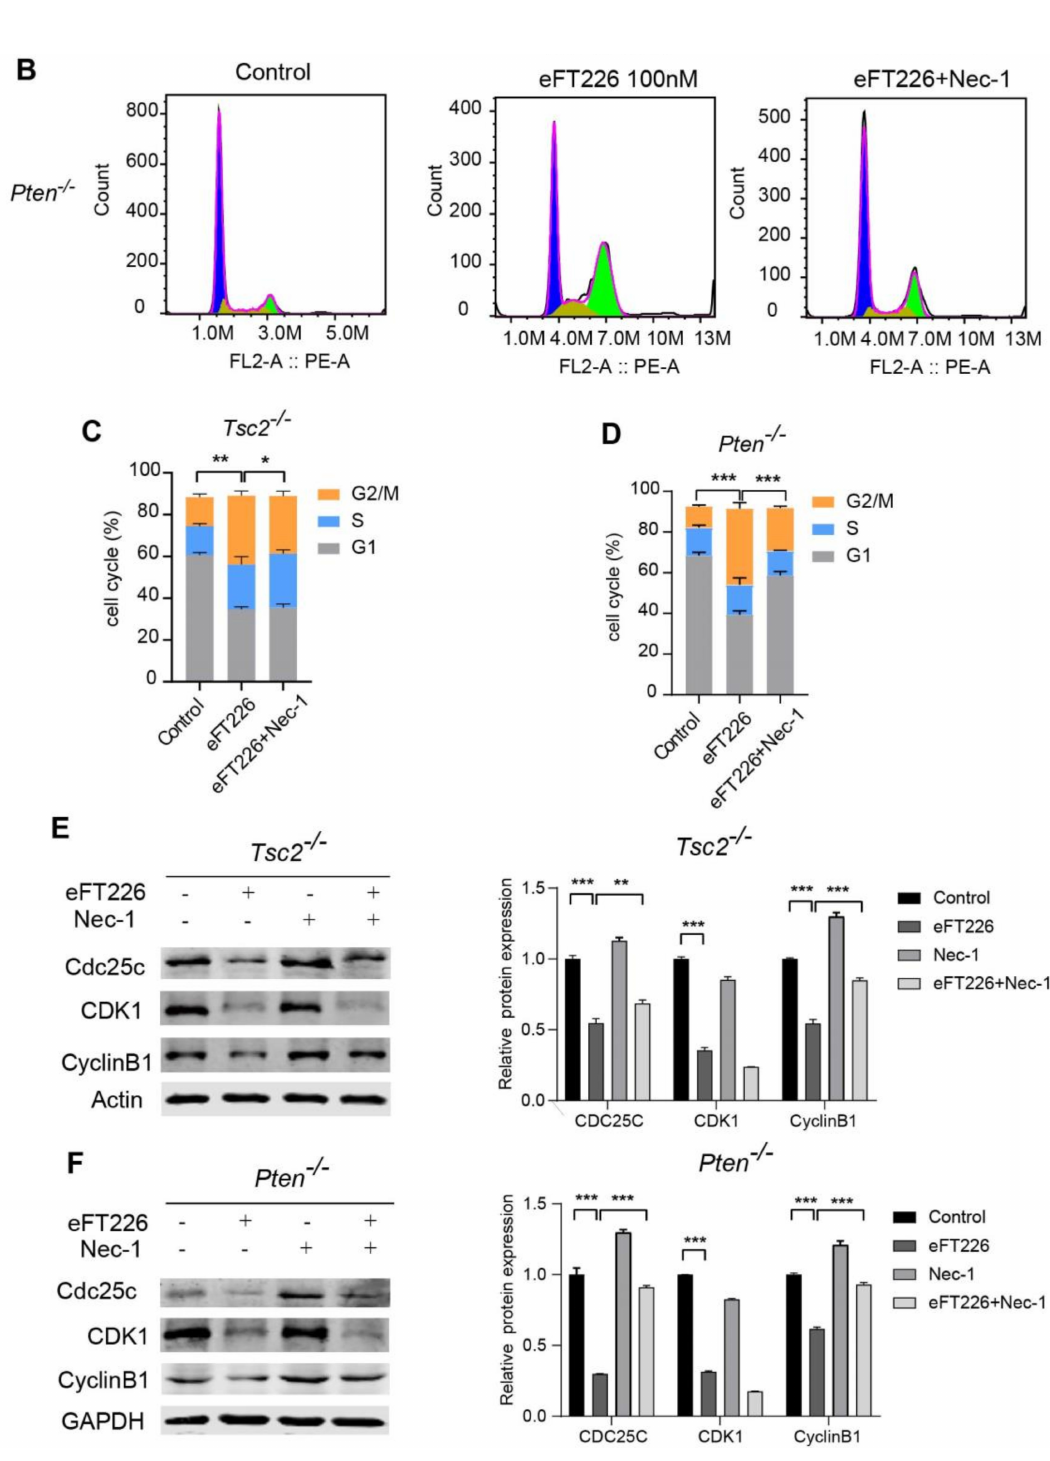
Figure 7. Nec-1 partially reverses G2/M arrest caused by eFT226 in Tsc2 - and Pten -deficient cells. ( A – D ) Tsc2 - ( A , C ) and Pten -deficient MEFs ( B , D ) were treated with eFT226 (100 nM) with or without Nec-1 (30 µ M) for 48 h in triplicate and cell cycle distribution was measured by PI staining followed by flow cytometry. The populations in G1, S and G2/M stages are shown in blue, yellow and green, respectively. ( E , F ) Tsc2 - and Pten -deficient MEFs were treated with eFT226 (100 nM) with or without Nec-1 for 48h and then subjected to immunoblotting. Quantitative analysis of the band density was shown in right panel. Error bars represent mean ± SD. * p < 0.05; ** p < 0.01; and *** p <